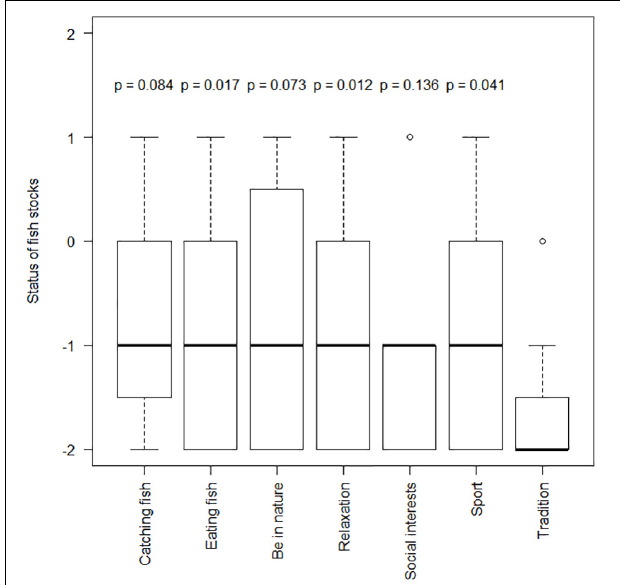
FIGURE 3 | Conservation status of fish stocks (from –2 meaning very negative to 2 meaning very positive) perceived by recreational fishers with different motivations for fishing. The top and bottom of the boxes correspond to the first and third quartiles of the data, the whiskers extend to 1.5 times the interquartile range and the median is indicated with a thick horizontal line. P -values of the paired t -tests estimated by GLM between fishers motived by family traditions and other motivations are also